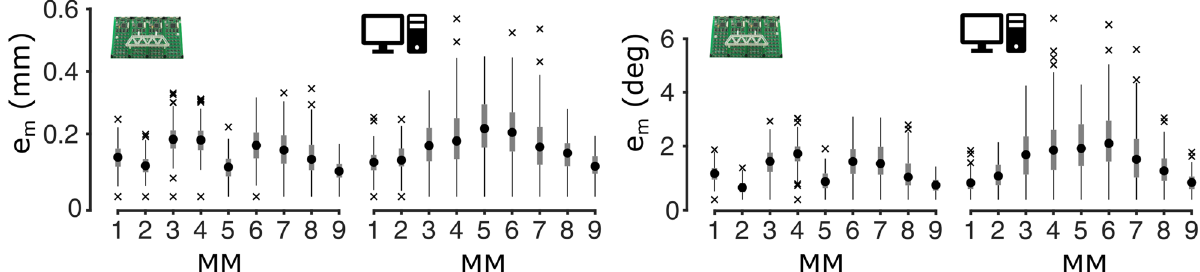
Figure 5. Displacement errors for both experimental (left) and simulated (right) data in the control test (θ = 51°). The crosses indicate the outliers, the boxplot encloses data within the interquartile range, the black dot is the median value, while the whiskers extend to the limits of the distribution. Results obtained with the two systems were comparable. Maximum median position (orientation) errors of 0.18 mm (1.72°) and of 0.22 mm (2.01°) were obtained for the experimental and the simulated setup,